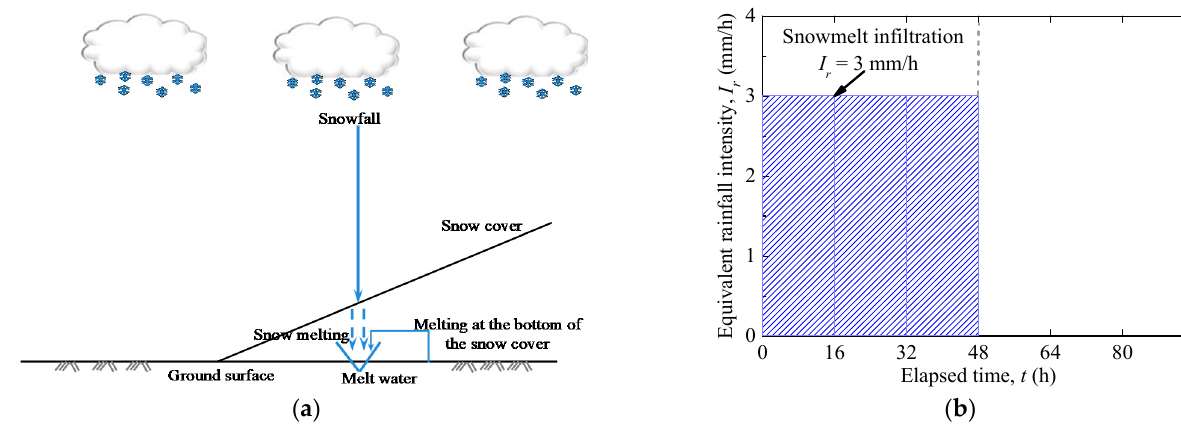
Figure 5. S chematic view of ( a ) the process of snowmelt infiltration (after [33]) ( b ) and the equivalent rainfall infiltration.